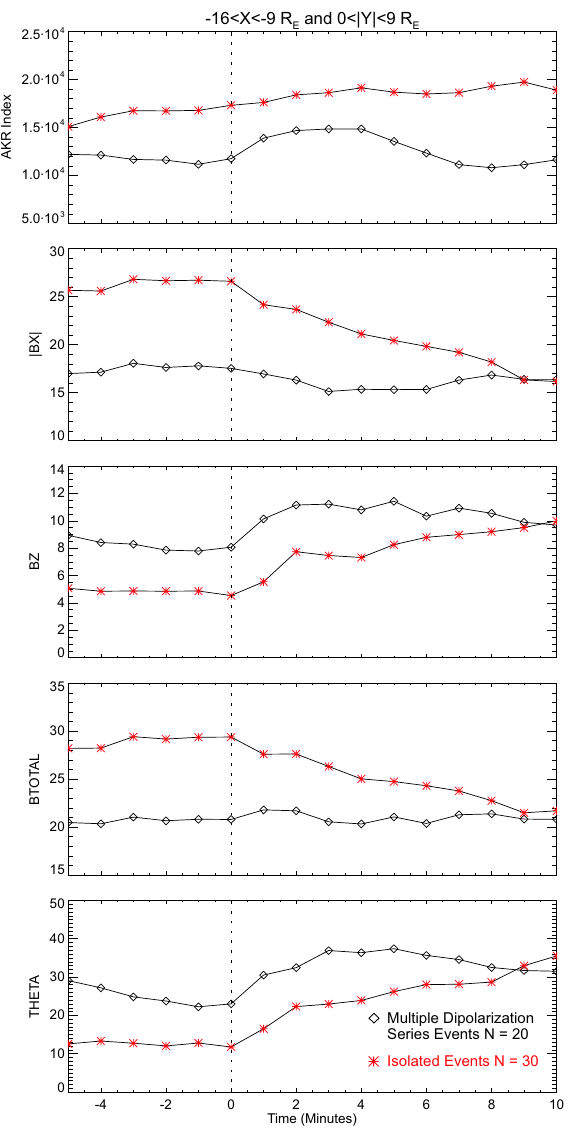
Superposed epoch comparison of the magnetic field changes during the multiple dipolarization series events and isolated dipolarization events. We used 1min averages of the magnetic field in the regions 0 < | Y | < 9 R E and − 16 <X< − 9 R E . The absolute value of B x is plotted to prevent B x from averaging to